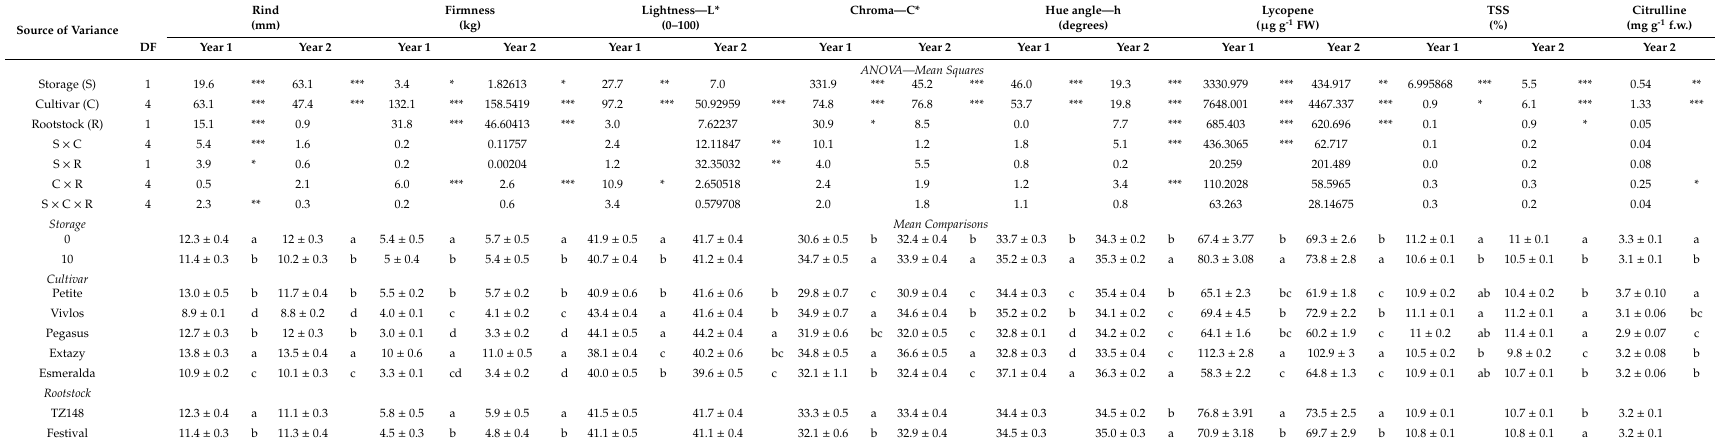
Table 2. Fruit rind thickness, pulp firmness, pulp CIELAB color components (Lightness—L*, Chroma—C* and Hue angle—h), lycopene content, total soluble solids (TSS), and citrulline content in watermelon fruit of cvs. Petite, Vivlos, Pegasus, Extazy and Esmeralda grafted on TZ148 and Festival rootstocks and stored for 10 days at 25 ◦ C. Values represent means ±